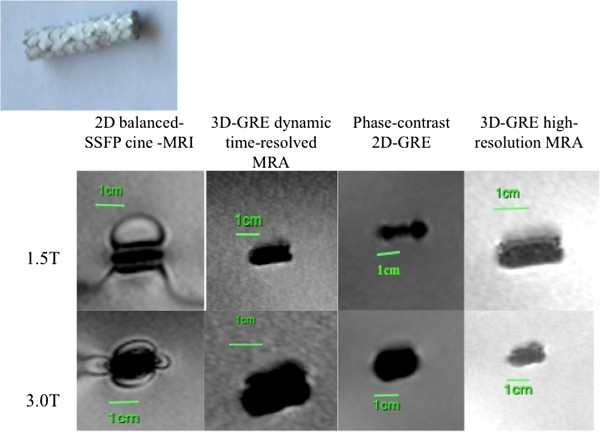
MR appearance of Jostent Coronary Stent Graft (Device 3).